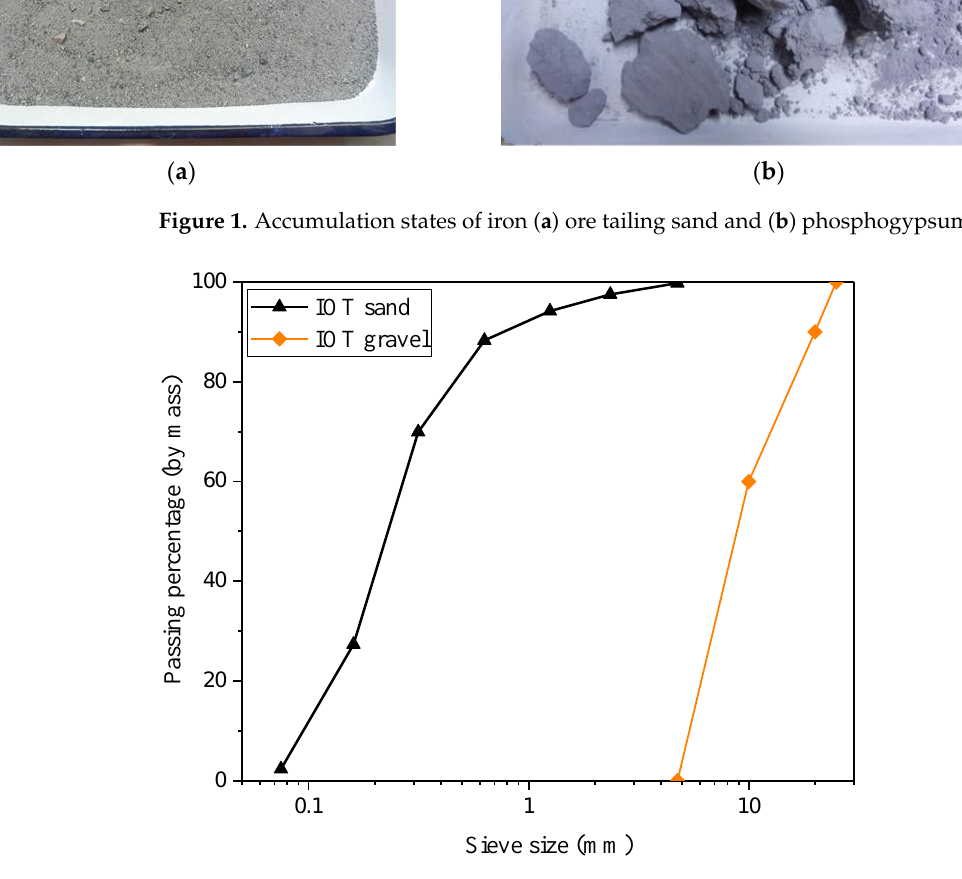
Figure 2. Particle size distribution curves of IOT sand and IOT gravel. Table 1. Chemical compositions of the PG, GBFS, steel slag and cement.